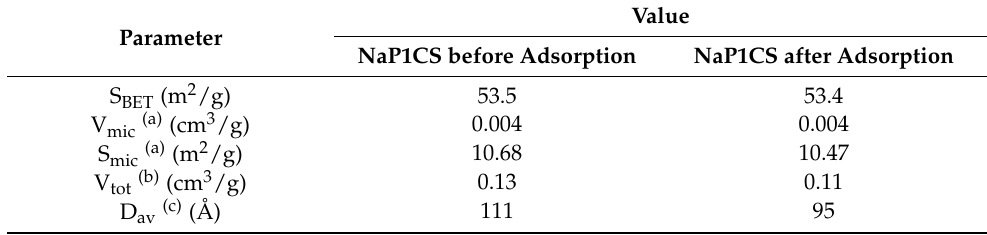
Table 3. Surface characteristics of NaP1CS before and after adsorption of Cu(II)–IDHA complexes.